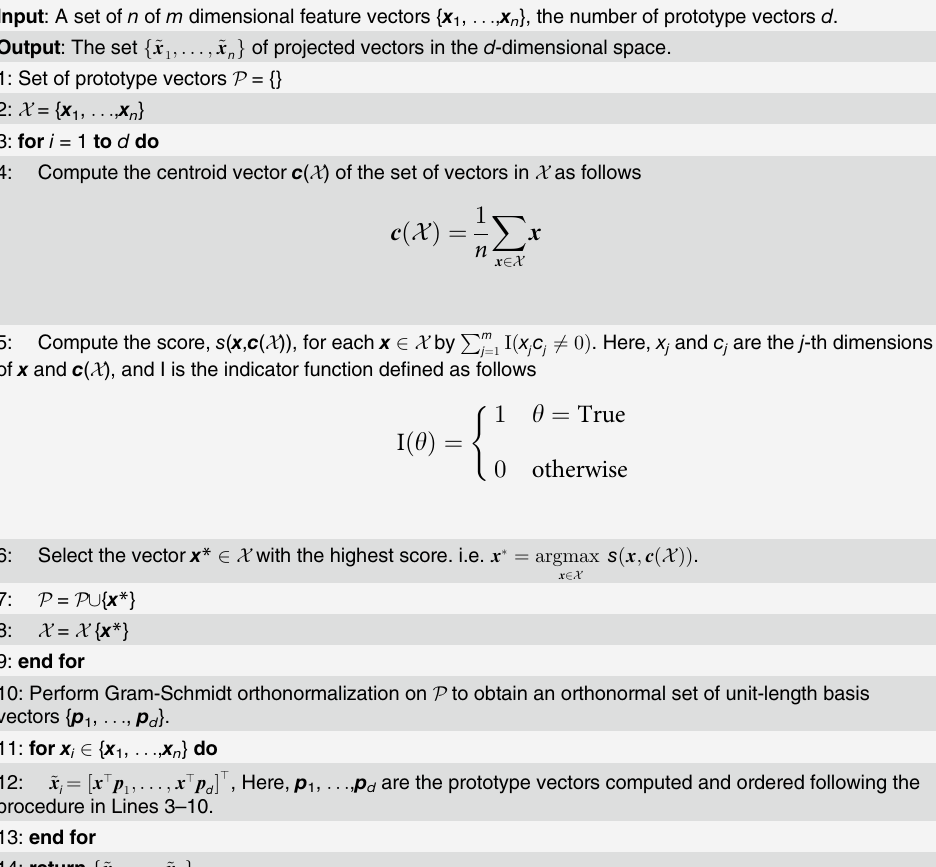
Table 1. Algorithm 1 Prototype Vector